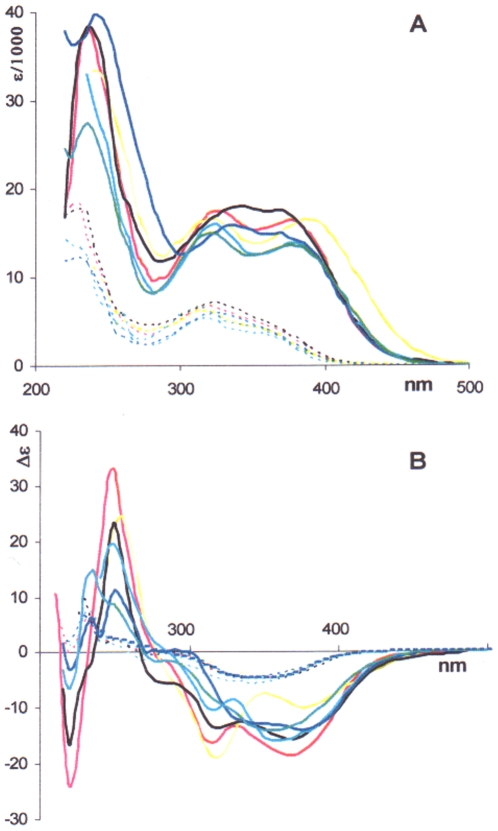
UV and CD spectra for isocolchicide and biisocolchcide.UV (A) and CD (B) spectra for biisocolchicide 5 (solid line) and isocolchicide 6 (dotted line) in various solvents are reported; ____: EtOH; ____: TFE; _
___: H2O; ____: MeCN; ____: CHCl3; ____: DMSO.